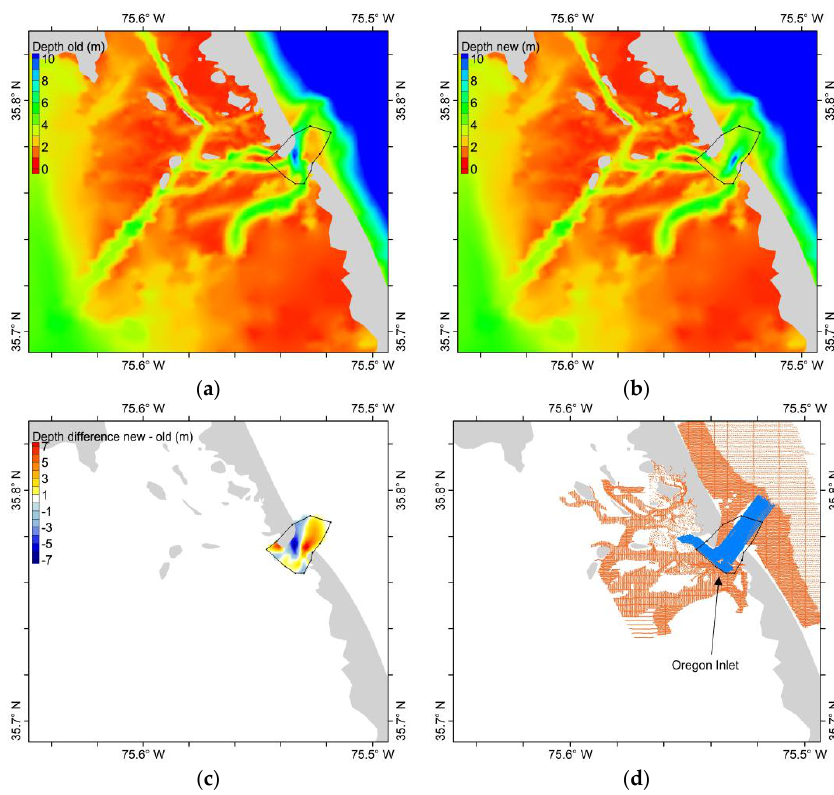
Figure 4. The morphological changes around Ocracoke Inlet and Hatteras Inlet: ( a ) the old-bathy grid depths; ( b ) the new-bathy grid depths; ( c ) the depth difference between the new-bathy grid and the old-bathy grid; ( d ) the original bathymetry sounding data points (orange: data in 1956 and 1962 around Ocracoke Inlet and data in 1935 around Hatteras Inlet; blue: data in 2013 around Ocracoke Inlet and data in 2014, 2015, and 2016 around Hatteras Inlet). The black dotted polygons delineate the area with changed bathymetry.